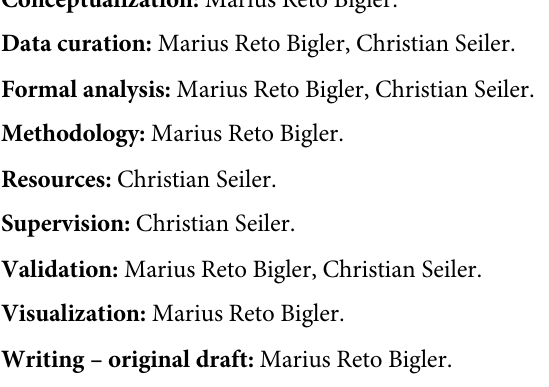
S7 Fig. Visualization of network activation patterns of GoogLeNet12. Red regions contrib- uted most to the network class prediction. (TIF) S8 Fig. Visualization of network activation patterns of ResNet10. Red regions contributed most to the network class prediction. (TIF) S9 Fig. Visualization of network activation patterns of ResNet8. Red regions contributed most to the network class prediction. (TIF) S10 Fig. Visualization of network activation patterns of GoogLeNet13. Red regions contrib- uted most to the network class prediction. (TIF) S11 Fig. Visualization of network activation patterns of all false prediction of ResNet5. Red regions contributed most to the network class prediction. While some predictions are understandable (left and right column), others are incomprehensible (middle column). (TIF) S1 Table. Nonparametric receiver-operating characteristic curves of manually determined icECG ST-segment shift and corresponding collateral flow index and heart rate. (DOCX) S2 Table. In-detail performance of the ten best performing